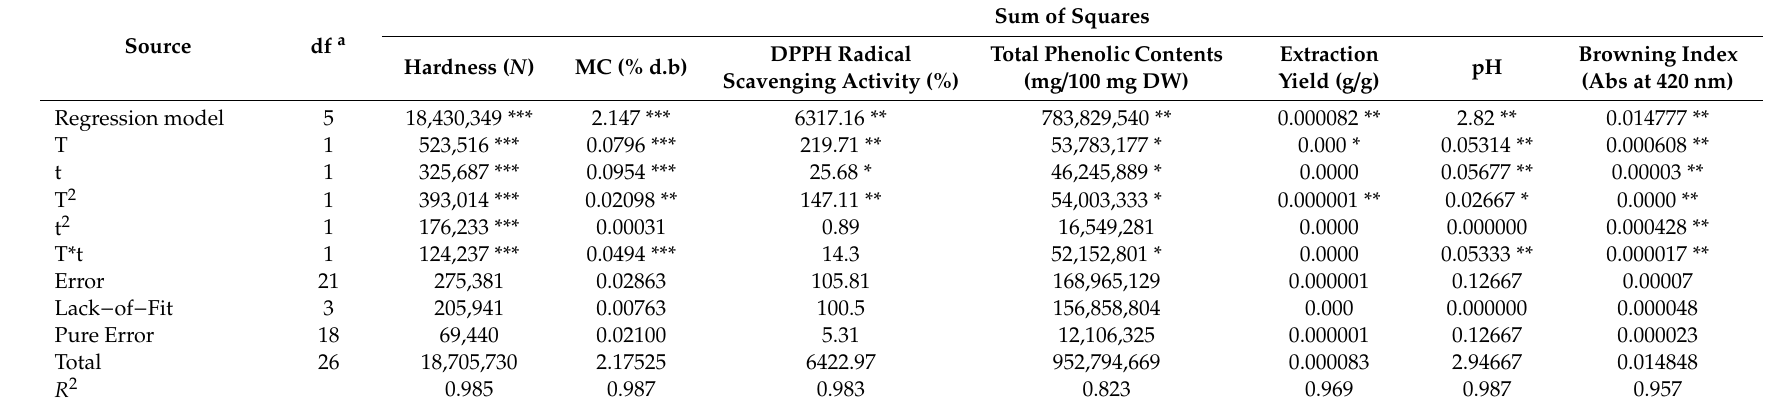
Table 3. Analysis of variance for the physical, antioxidative and quality properties of the whole date seeds, powder and brew.